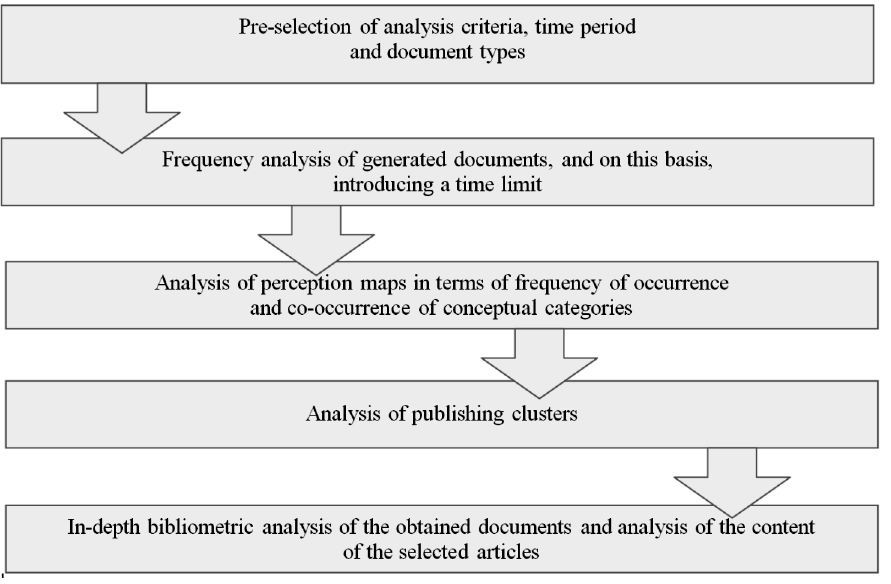
Figure 1. Stages of the research process